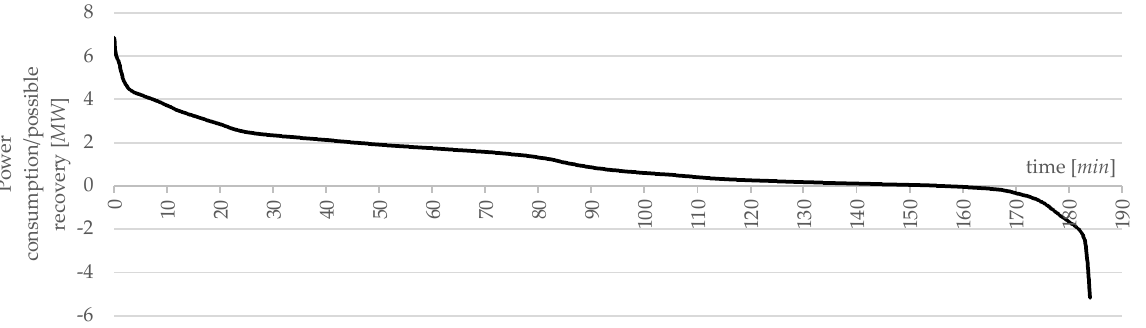
Figure 7. Power consumption/possible recovery in the variant after reconfiguration by the proposed algorithm.